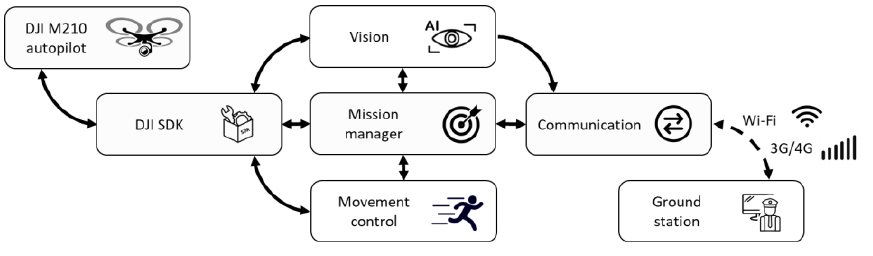
Figure 24. Software blocks.